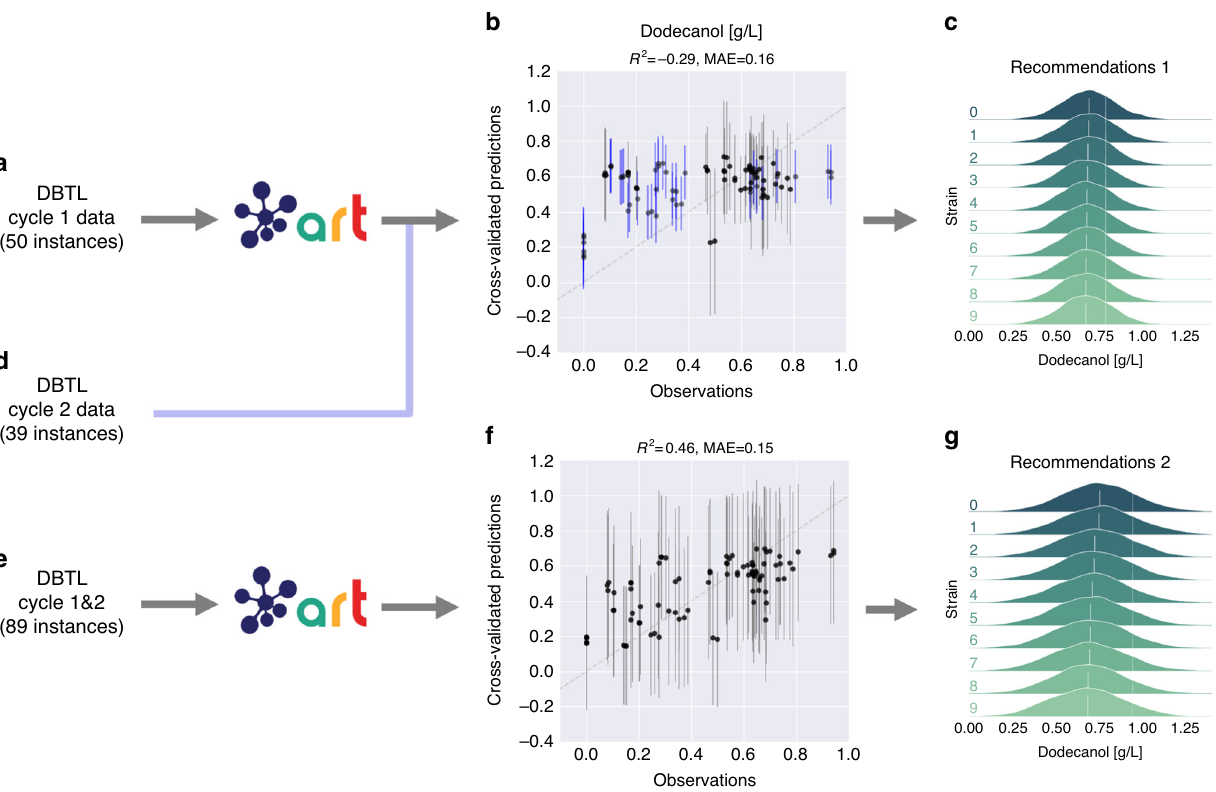
Fig. 9 ART ’ s predictive power is heavily compromised in the dodecanol case. Although the 50 instances available for cycle 1 of pathway 1 ( a ) almost double the 27 available instances for the limonene case (Fig. 6), the predictive power of ART is heavily compromised ( R 2 = − 0.29 for cross-validation, b ) by the scarcity of data and, we hypothesize, the strong tie of the pathway to host metabolism (fatty acid production). The poor predictions for the test data from cycle 2 (in blue) con fi rm the lack of predictive power. Adding data from both cycles ( d , e ) improves predictions notably ( f ). These data and model refer to the fi rst pathway in Fig. 1B from ref. 41 . The cases for the other two pathways produce similar conclusions (Supplementary Figs. 8 and 9). Recommendations provided in panels c and g . R 2 and mean absolute error (MAE) values are only for cross-validated mean predictions (black data points). Bars indicate 95% credible interval of the predictive posterior